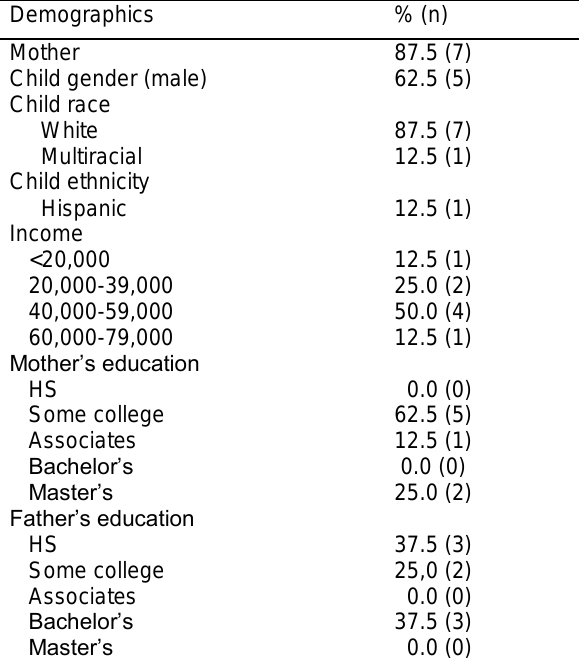
Table 1. Participant Demographics